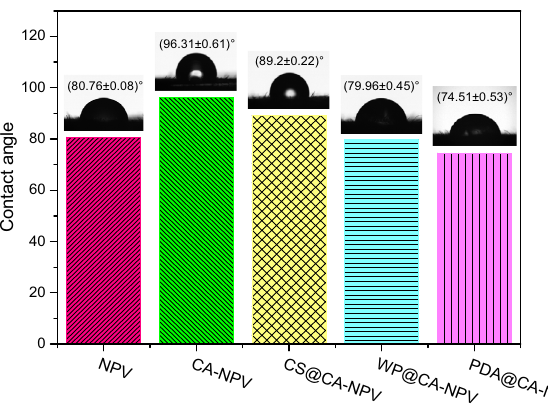
Figure 7. Contact angle of SeNPV OBs and four microencapsulated preparations. To determine the contact angles of the samples, diluted microcapsule formulations, and SeMNPV OBs were used as a control. The sample was dropped onto the surface of a cucumber leaves. The contact angle was measured using a contact angle meter. The contact angles of SeMNPV and microcapsule preparations varied, from small to large, in order as